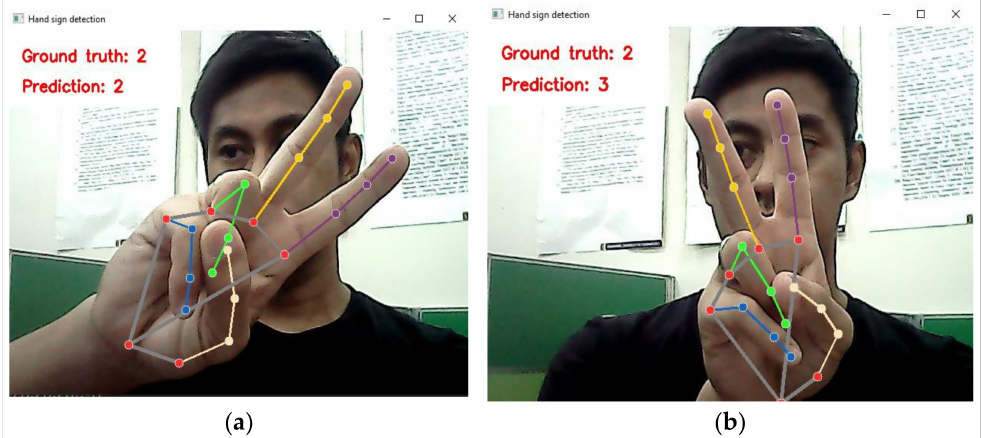
Figure 9. Prediction result using Dataset 3 and 10 features: ( a ) correct prediction; ( b ) incorrect